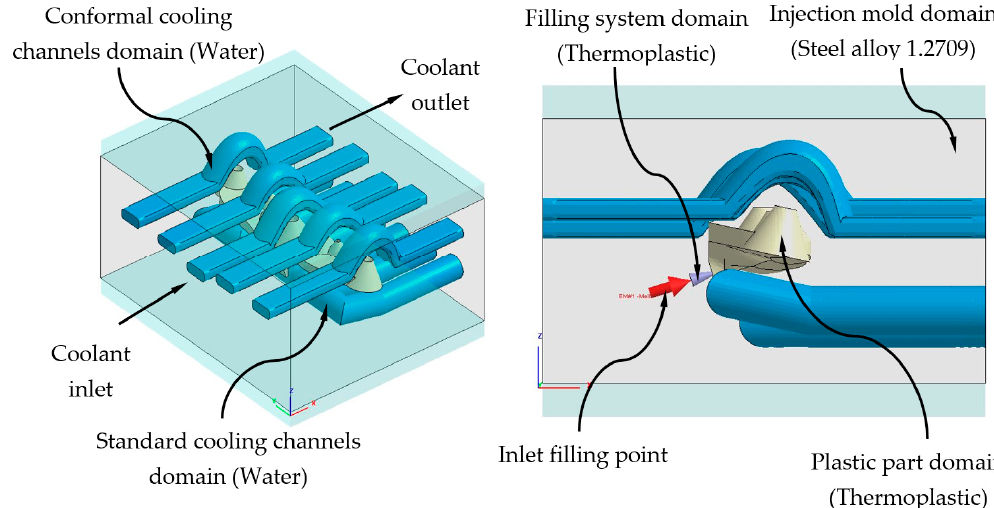
Figure 13. Domains and boundary conditions definition for the numerical simulations, conformal cooling solution.